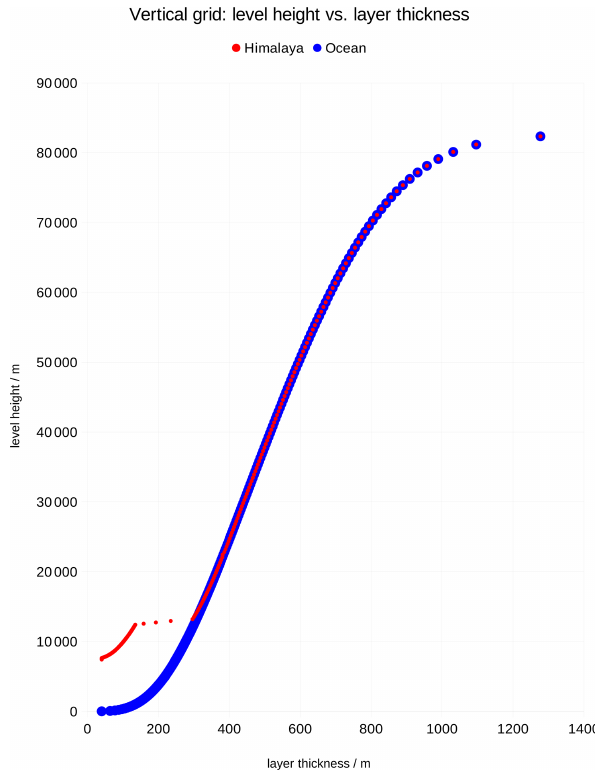
Figure 1. Level height vs. layer thickness from the surface to the model top for a surface height of 0m over ocean (blue) and for the highest surface point of the R2B9 grid at 7368m at 27 ◦ 55 (cid:48) 52 (cid:48)(cid:48) N, 87 ◦ 6 (cid:48) 45 (cid:48)(cid:48) E in the Himalayas (red). The lowermost layer has a con- stant thickness of 40m and thus is centered at 20m height above the surface. The uppermost layer is centered at 82361m and has an upper bound at 83000m. At heights above 22500m, the vertical resolution profile is independent of the surface